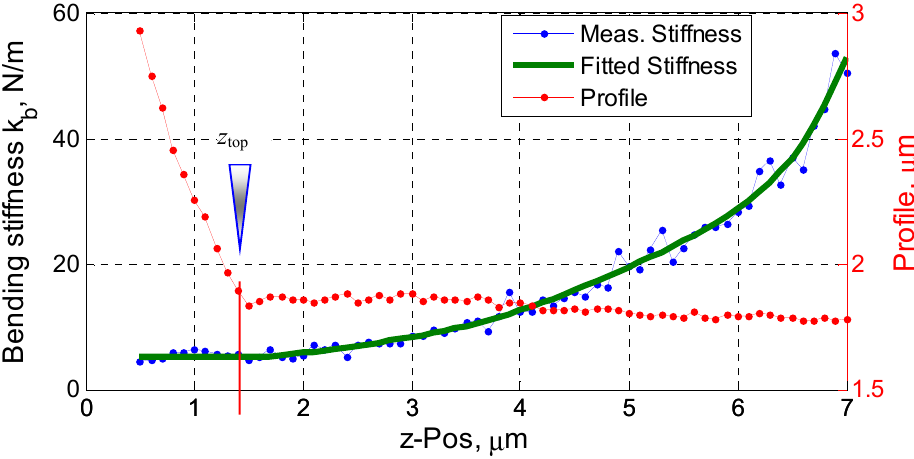
Figure 10. Measured profile and the bending stiffness of the pillar with respect to its axial positions.